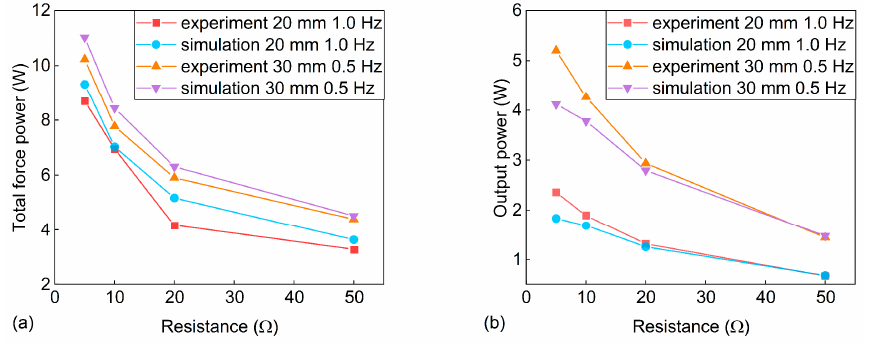
Figure 9. Simulation and experiment in a cycle. ( a ) Total force power. ( b ) Energy harvesting output power.